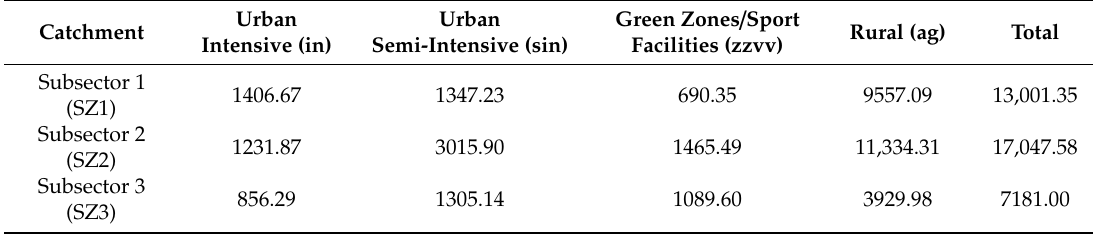
Table 3. Land use areas (10 4 m 2 ) by